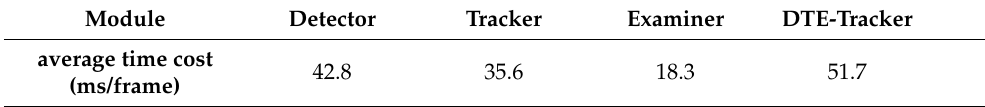
Table 1. The average time cost of each module on Xavier NX.